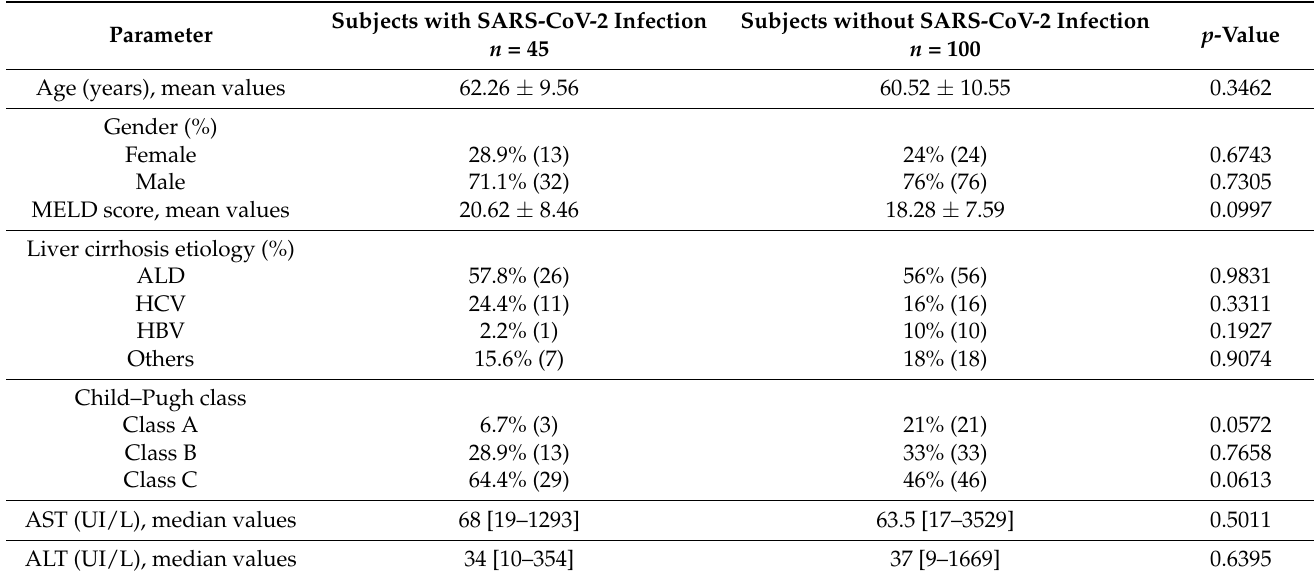
Table 1. Demographic and clinical characteristics of the included